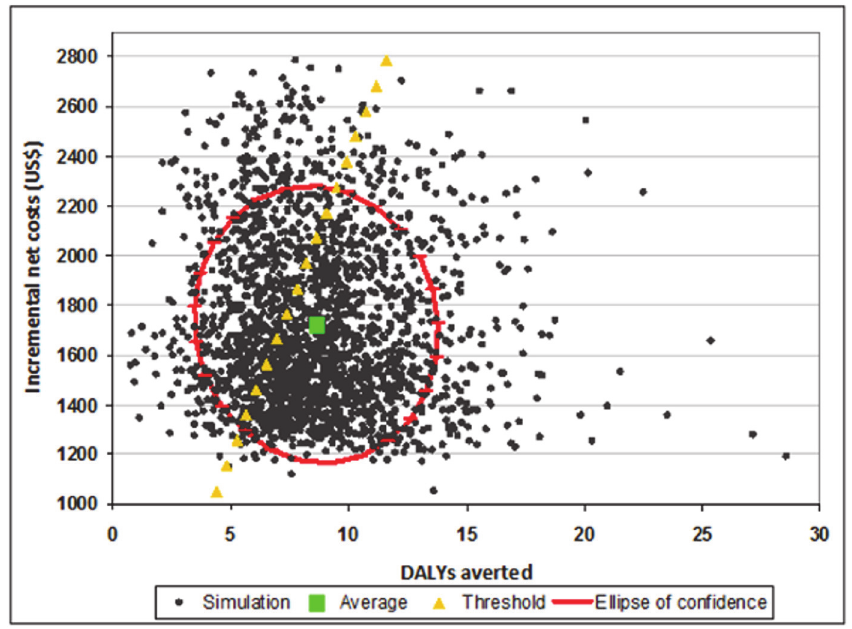
Fig 3. Cost effectiveness plane: IPTp-MQ versus IPTp-SP in HIV-negative pregnant women in Benin, Mozambique and Tanzania. IPTp-MQ = Intermittent Preventive Treatment of malaria in pregnancy with Mefloquine; IPTp-SP = Intermittent Preventive Treatment of malaria in pregnancy with Sulphadoxine- Phyrimethamine; HIV = Human Immunodeficiency Virus; DALYs = Disability-adjusted life years. The graph plots N = 2,000 Monte Carlo simulations of the incremental cost-effectiveness ratio (ICER) with respect to its components: health impact (X-axis) and incremental costs (Y-axis). Average simulation point, ellipse of confidence (95%) and threshold level of the ICER (240 US$/DALY averted) are also depicted. Cost-effective dots are placed below/right the threshold line.